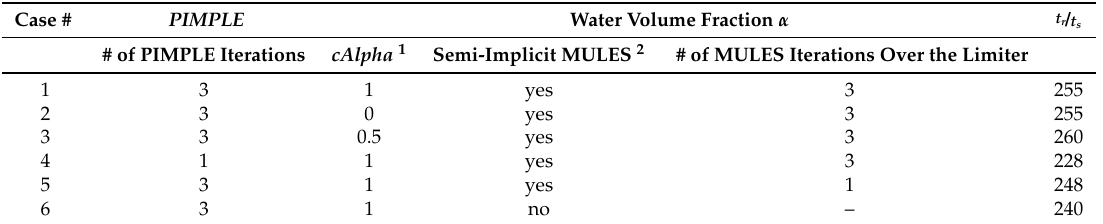
Table 9. Test matrix for the sensitivity analysis to numerical solver